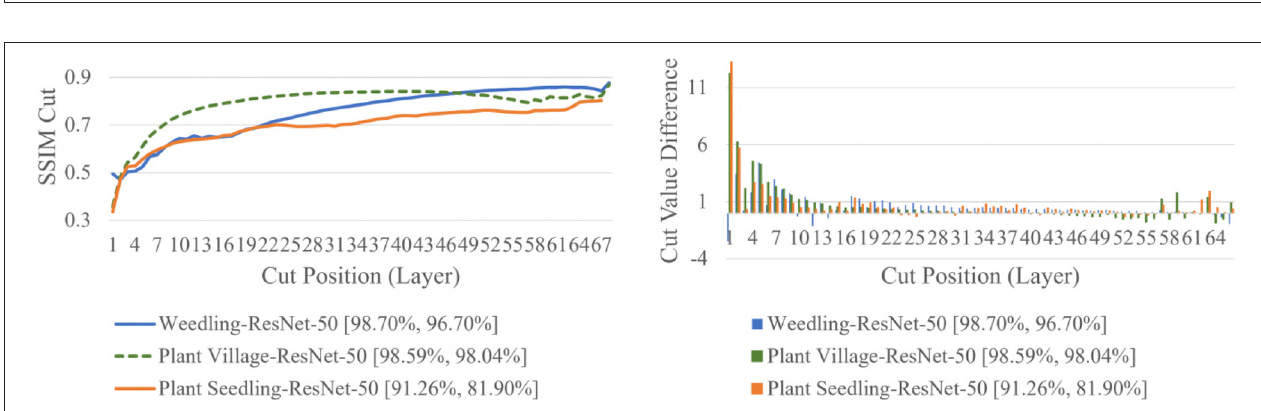
FIGURE 4 | Comparison of the Cut Position (Layer) VS SSIM cut curve, and Cut Value Difference for the ResNet-50 models for different datasets. The value in the legend of the chart indicate the training and testing accuracy of the model.